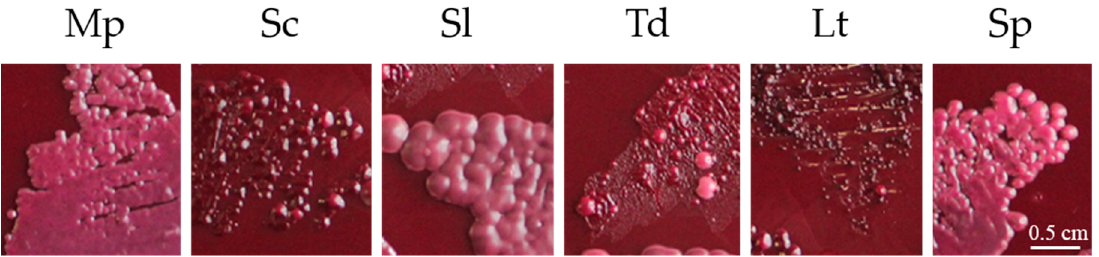
Figure 5. Adsorption of grape anthocyanins in yeast cell walls ( Saccharomyces and non- Saccharomyces ) during growth in a specific plating medium containing pigments. Metschnikowia pulcherrima ( Mp ), Saccharomyces cerevisiae ( Sc ), Saccharomycodes ludwigii ( Sl ), Torulaspora delbrueckii ( Td ), Lachancea thermotolerans ( Lt ), Schizosaccharomyces pombe ( Sp ).